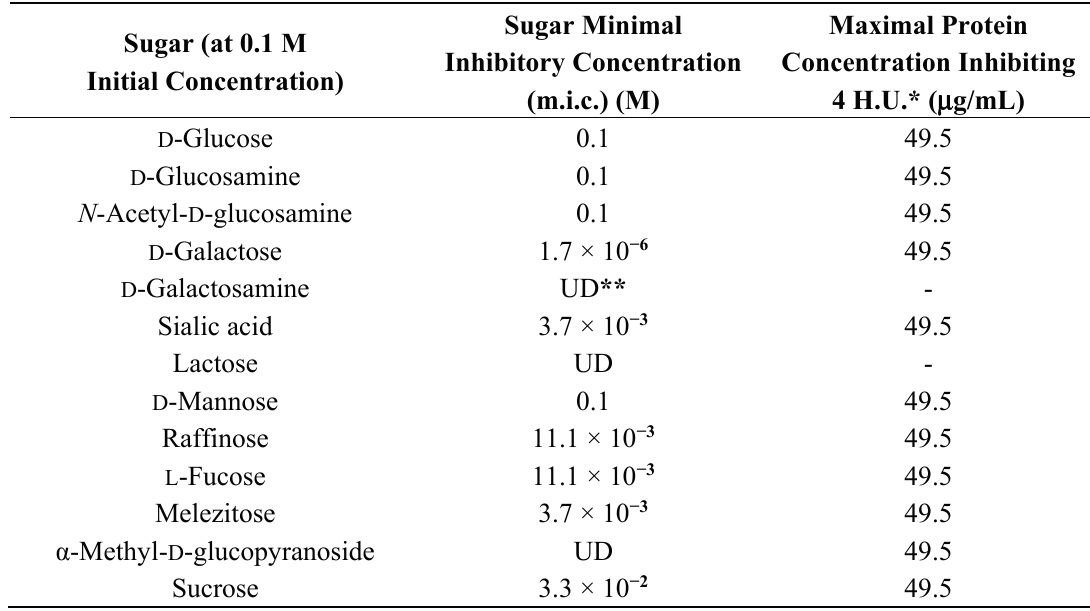
Table 1. Sugar inhibition analysis of the haemagglutination activity of L. albus albumin